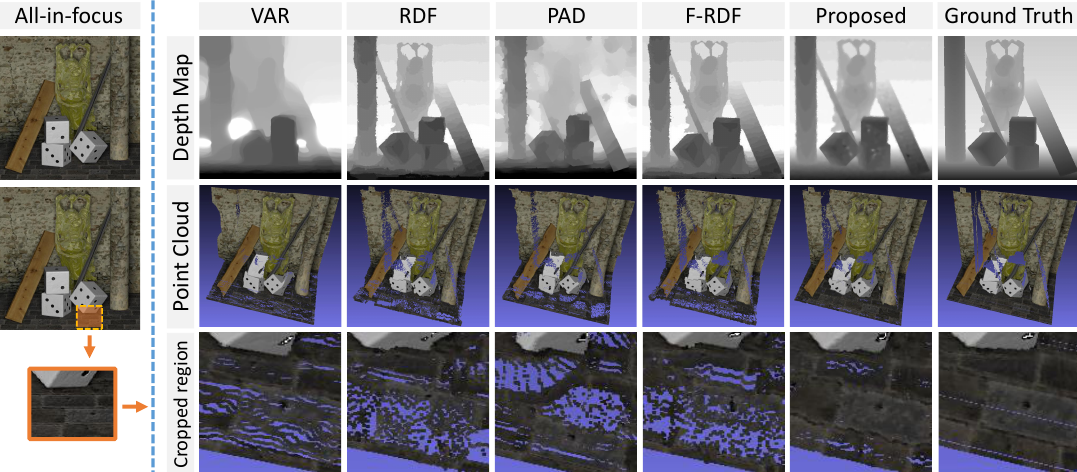
Figure 14. Comparison of point cloud of the scene with state-of-the-art methods. First row shows depth map, second: point cloud results, and last row shows cropped (zoomed-in) region of the scene. The proposed method provide with correct depth value when most methods fail (at cropped